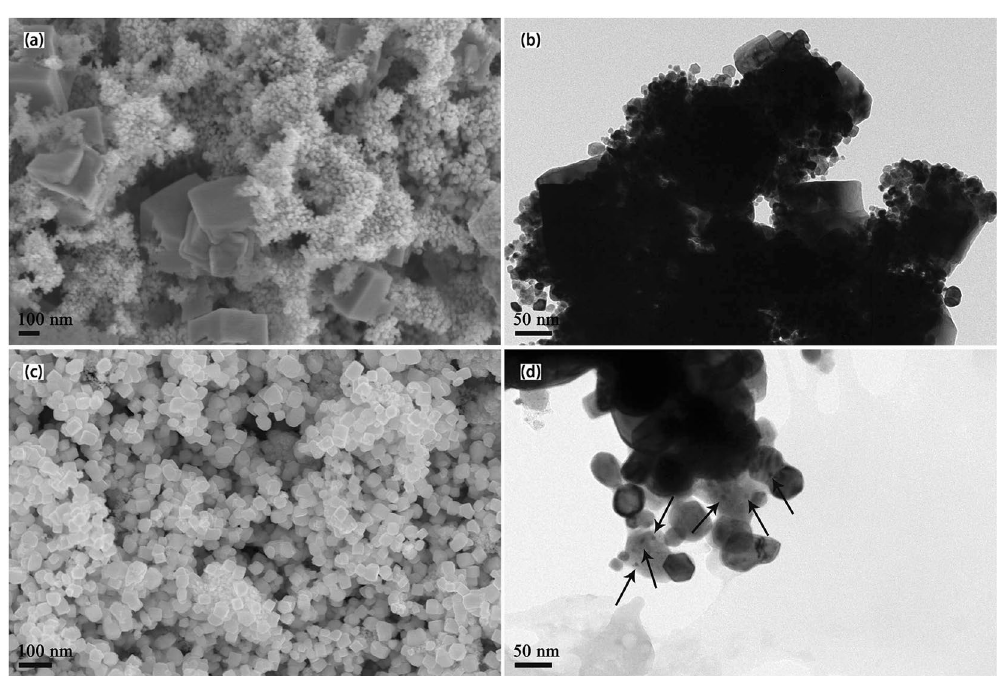
Figure 2. ( a ) SEM images of the reduced W-Y 2 O 3 composite powder precursor fabricated by traditional wet chemical method, ( b ) TEM images of the reduced W-Y 2 O 3 composite powder precursor fabricated by traditional wet chemical method, ( c ) SEM images of the reduced W-Y 2 O 3 composite powder precursor fabricated by improved wet chemical method and ( d ) TEM images of the reduced W-Y 2 O 3 composite powder precursor fabricated by improved wet chemical